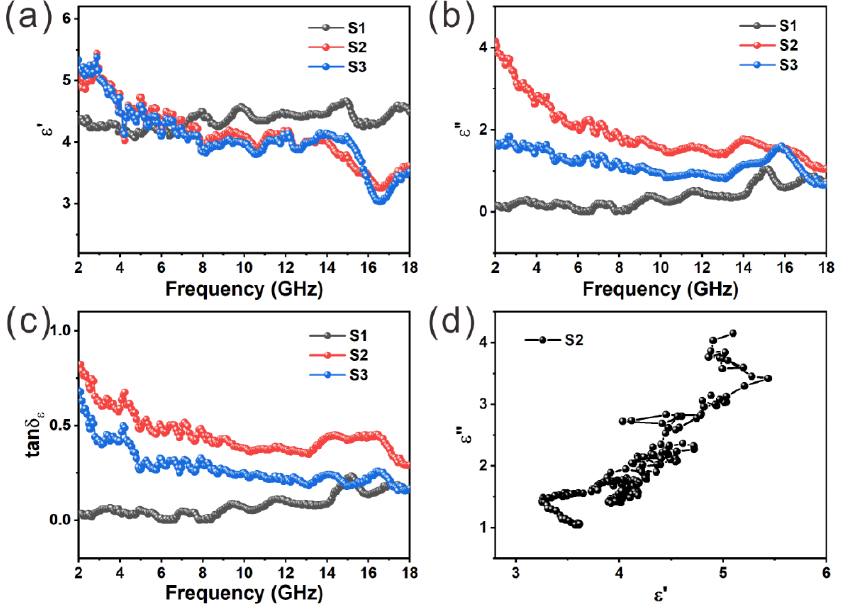
Figure 6. The real part ( a ) and imaginary part ( b ) of complex permittivity; ( c ) the dielectric loss tangent; ( d ) the Cole–Cole plot of S2.